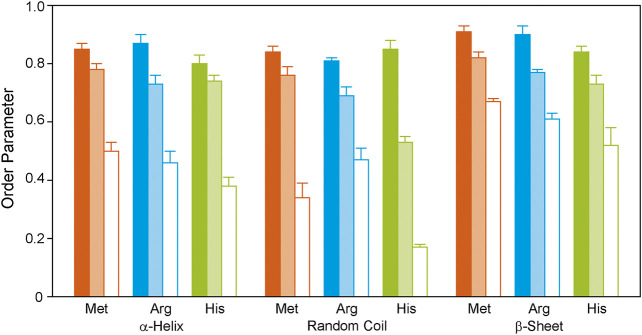

1H-13C DIPSHIFT order parameters of the backbone Cα atoms of isotopically labeled GHSR reconstituted in DMPC membranes determined at 37°C. Methionines were labeled to represent the transmembrane region (orange), arginine residues were labeled to provide information on the dynamics of the ends of the helices and loops (blue), and histidine residues report the dynamics of the C-terminus (green). Order parameters of NMR signals assigned to α-helical, random coil, and β-sheet secondary structures are shown as bars. Order parameters were determined from DIPSHIFT experiments using CP contact times of 20 µs (filled bars), and 700 µs (pale bars), as well as direct polarization (open bars). Error bars reflect the standard error of the mean. Exemplary DIPSHIFT spectra and dephasing curves used to calculate the order parameter are given in 
Supplementary Figure S5
.